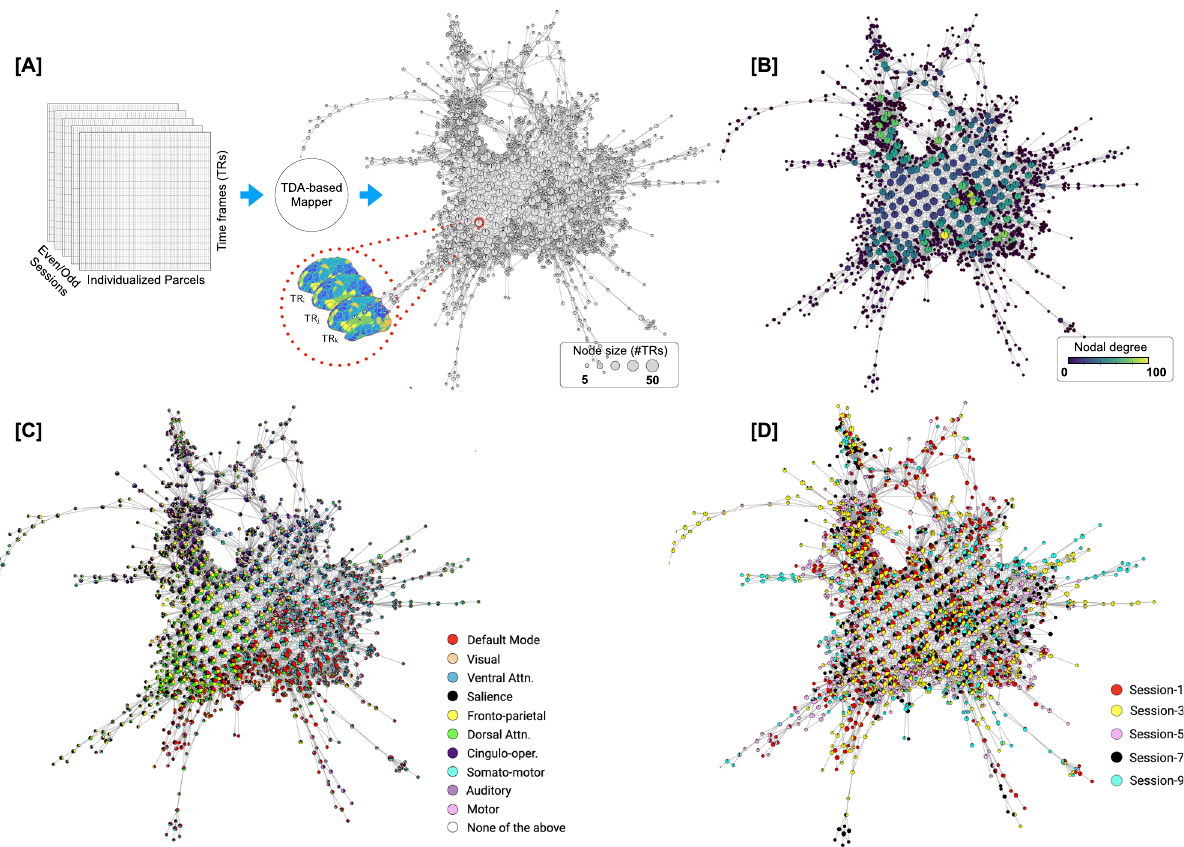
B The Mapper-generated graph can be characterized in several ways. Here, we examinetopologicalpropertiesbyannotatingthegraphnodesusingnodaldegree. C The graph can also be annotated with meta-information to characterize the mesoscale structure. Here, we show annotation using the activation of individual- speci fi c resting-state networks (RSNs). A pie-chart-based annotation is used to reveal the proportion of time frames with each node belonging to different RSNs. D Similarlythegraphcanalsobeannotatedusingotheravailablemeta-information, e.g., session